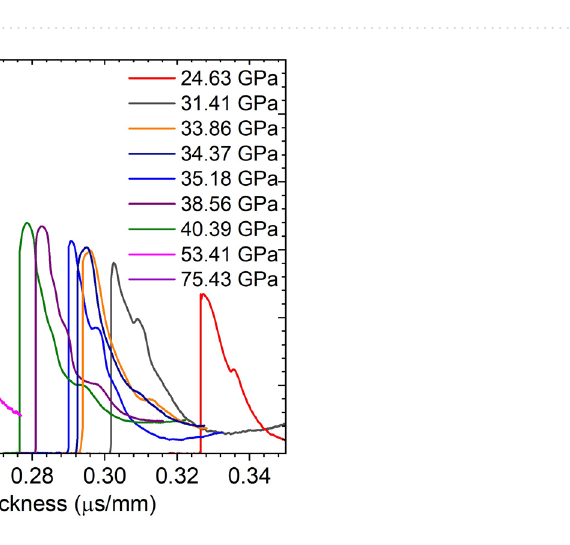
Figure 11. x-t diagram for selected shots showing the pressure variation across the sample for 15 and 25 µ m thick